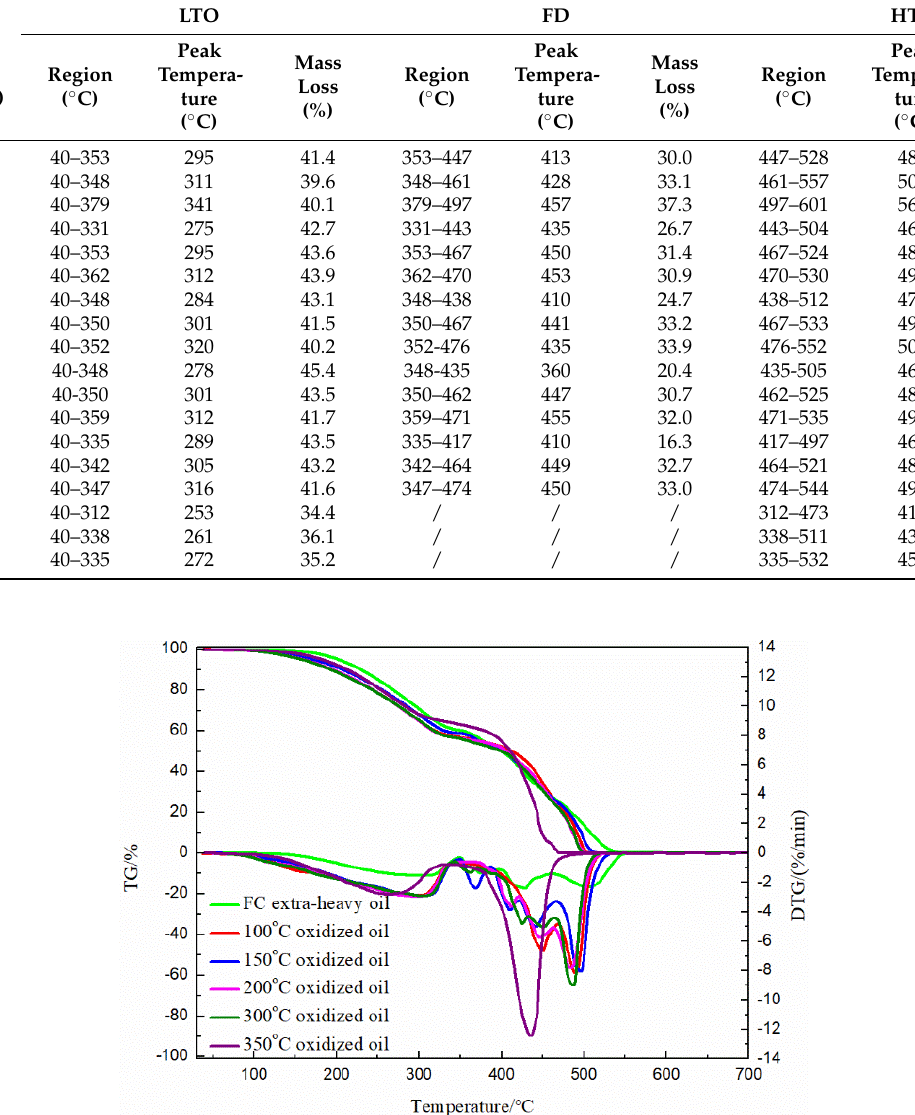
Figure 7. TG/DTG curves of FC extra-heavy oil and oxidized oils at 10 o C/min.